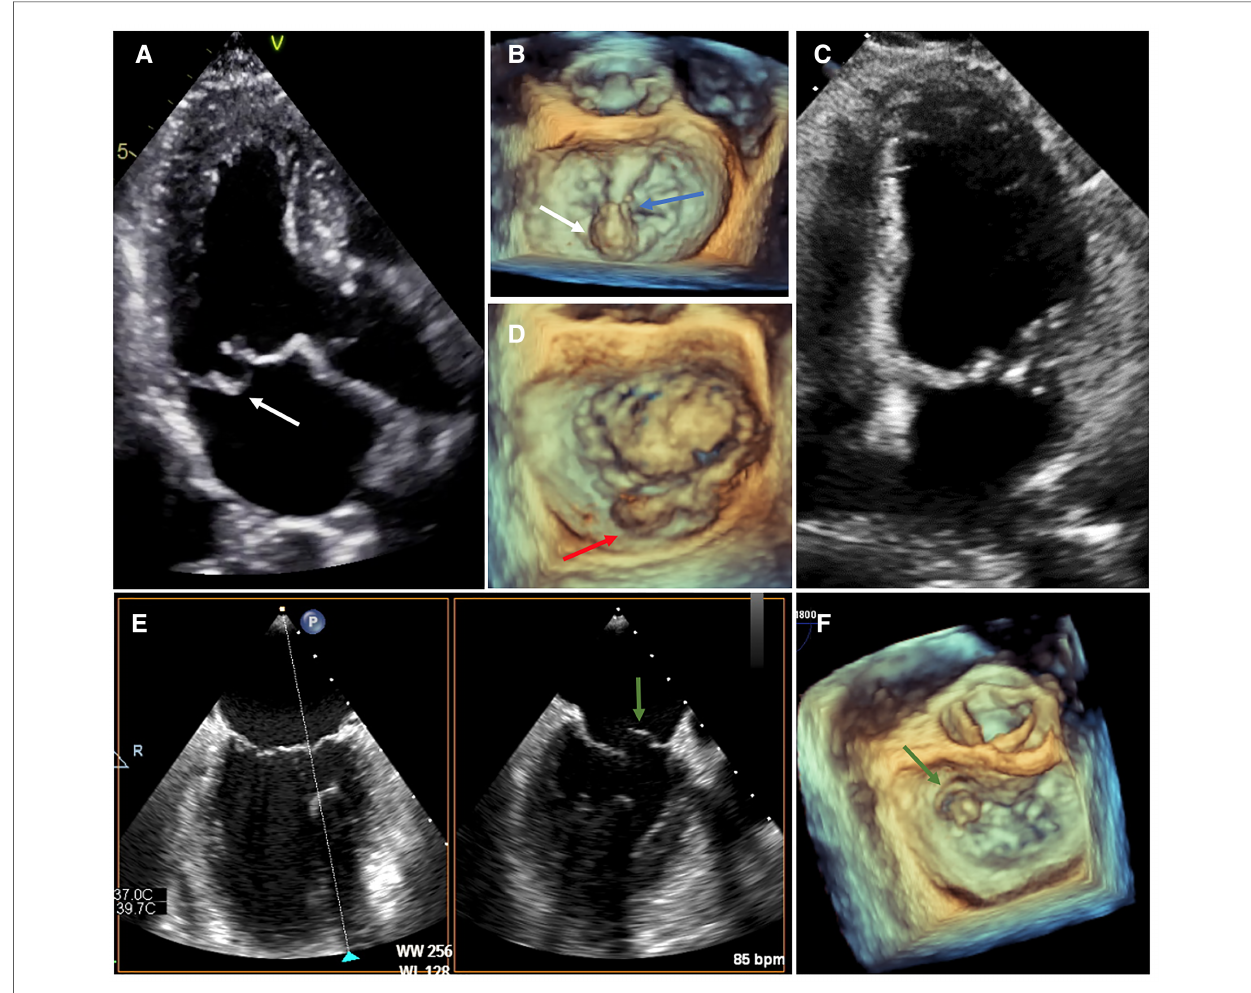
FIGURE 2 Morphological assessment of fl ail lea fl et. ( A,B ) Patient with posterior fl ail lea fl et visible on TTE (the tip is directed towards the LA). TEE con fi rms the involvement of segment P2 (white arrow) with chordae rupture (blue arrow). ( C,D ) Patient with bi-lea fl et MV prolapse and P2 fl ail (red arrow) only visible on 3D-imaging TEE (surgical “ en face ” view). ( E,F ) Patient with fl ail involving the segment A1 (green arrow) visible on TEE imaging using biplane mode from the bi-commissural view (60 – 90°), and on 3D-imaging (surgical “ en face ” view). LA, left atrium; TTE, transthoracic echocardiography; TEE, transesophageal